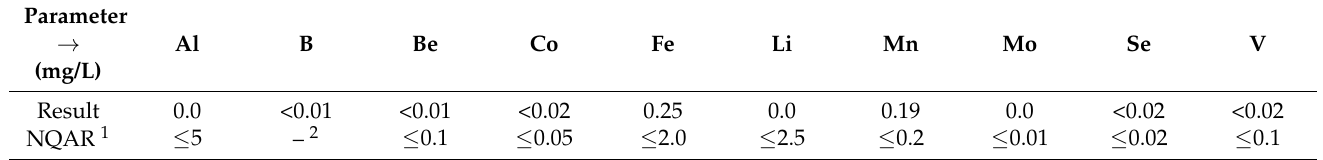
Table 3. Contents in heavy metals of the reclaimed water after tertiary treatment by the pilot-scale constructed wetland.